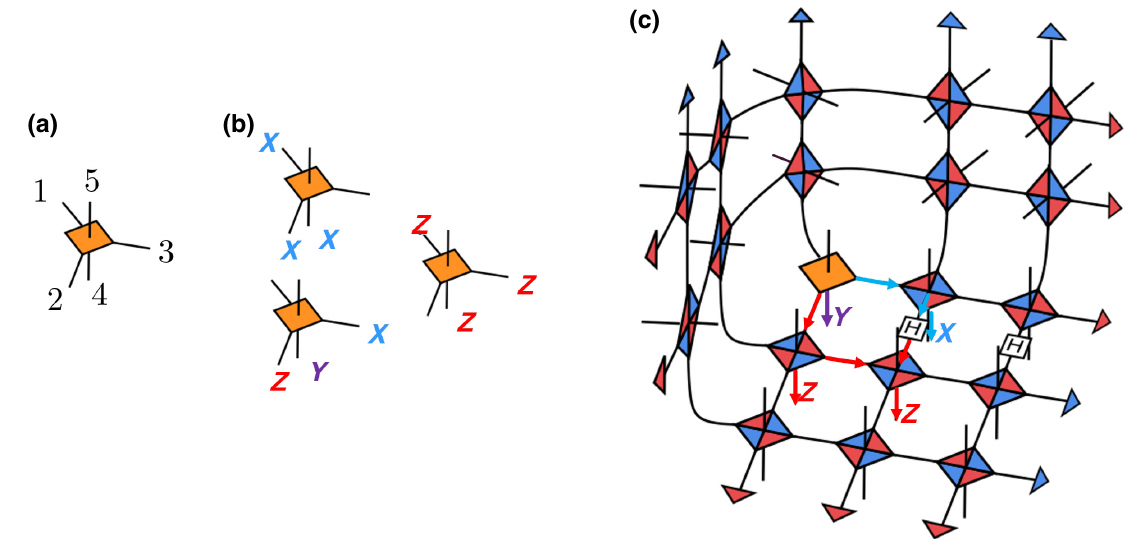
FIG. 20. (a) The four-qubit code tensor. (b) Stabilizer generators of the four-qubit code. (c) The tensor network that corresponds to a distance-5 triangle code. White squares marked with “ H ” are the 2 × 2 matrix representation of the Hadamard gate. The orientation of the orange tensor is the same in all subfigures.